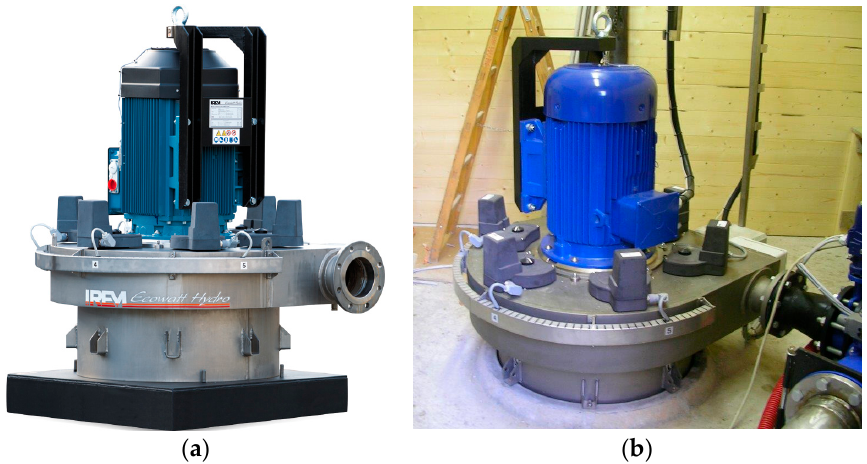
Figure 4. The proposed 6-jets distributor Pelton turbine. ( a ) general view. ( b ) an example of